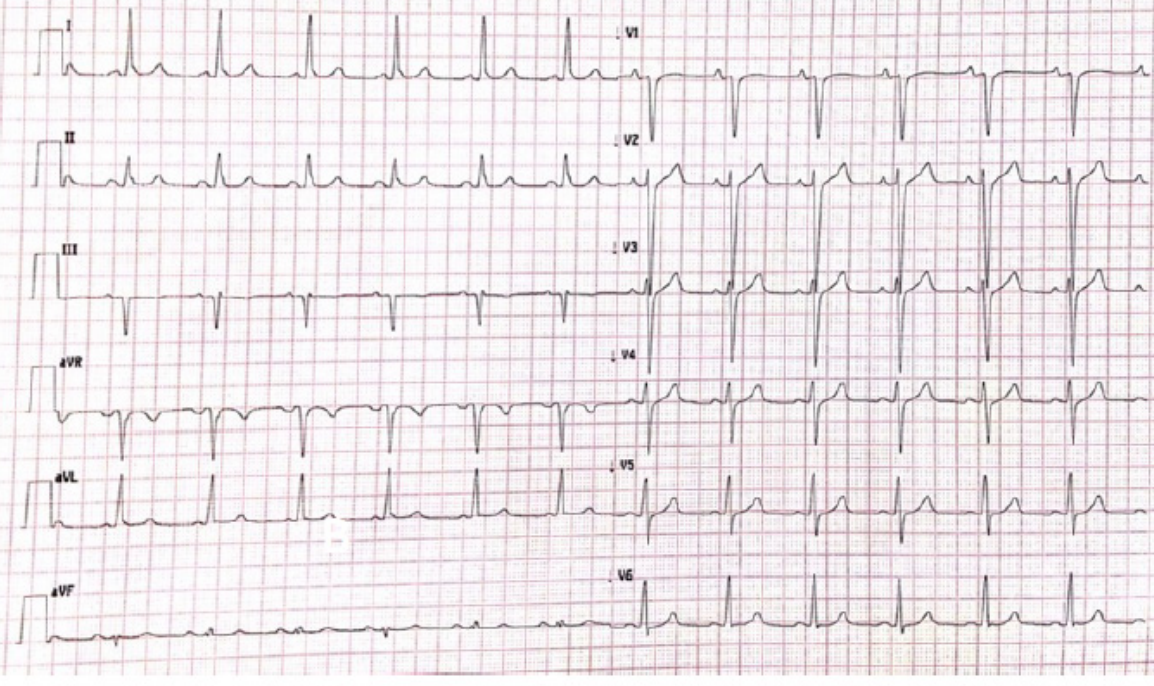
Figure 4. ( A ). Patient’s electrocardiogram at presentation. ( B ). Patient’s electrocardiogram after PCI showing new-onset atrial fibrillation with a high ventricular rate. 1.3. Patient 3 A 64 year old man with hypertension, hypercholesterolemia, AF, and moderate CKD was admitted to our department with chest pain. Eighteen months prior, he had non-STEMI (NSTEMI) treated with PCI and implantation of a DES on LAD, ramus intermedius (RI), and right coronary artery (RCA). He had no liver disease. Medical treatment included warfarin, 100 mg of aspirin daily, 5 mg of bisoprolol daily, 5 mg of ramipril b.i.d., and 40 mg